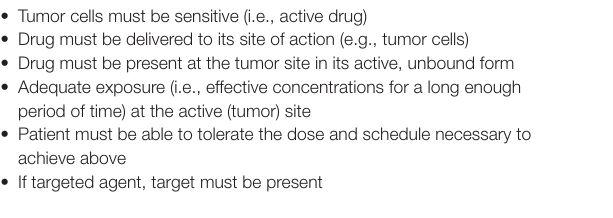
TaBle 1 | Requirements for anti-tumor drug